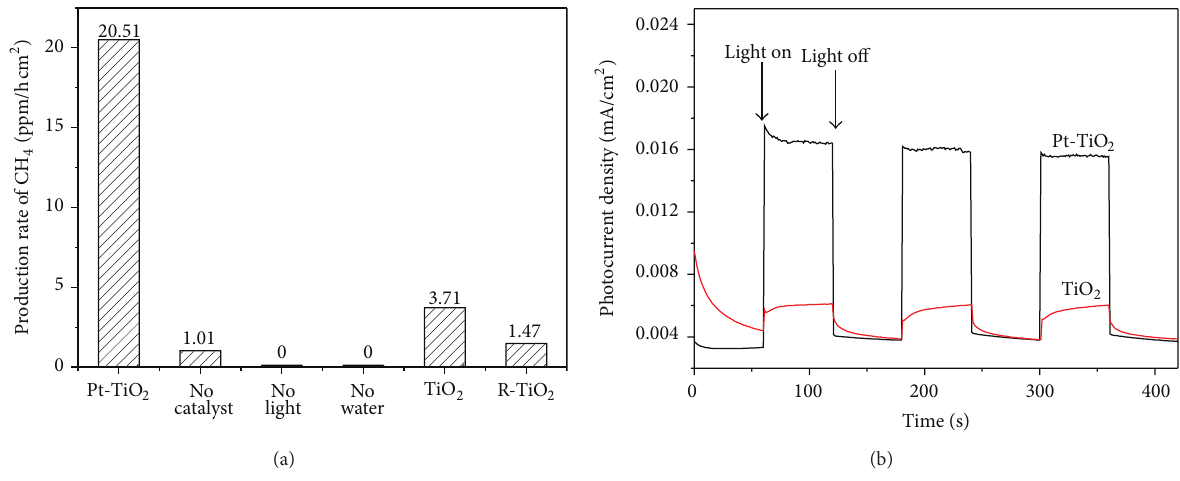
Figure 4: Evolution yield of CH 4 and photocurrent-time curve of TiO 2 and Pt-TiO 2 network film under UV irradiation in same conditions.